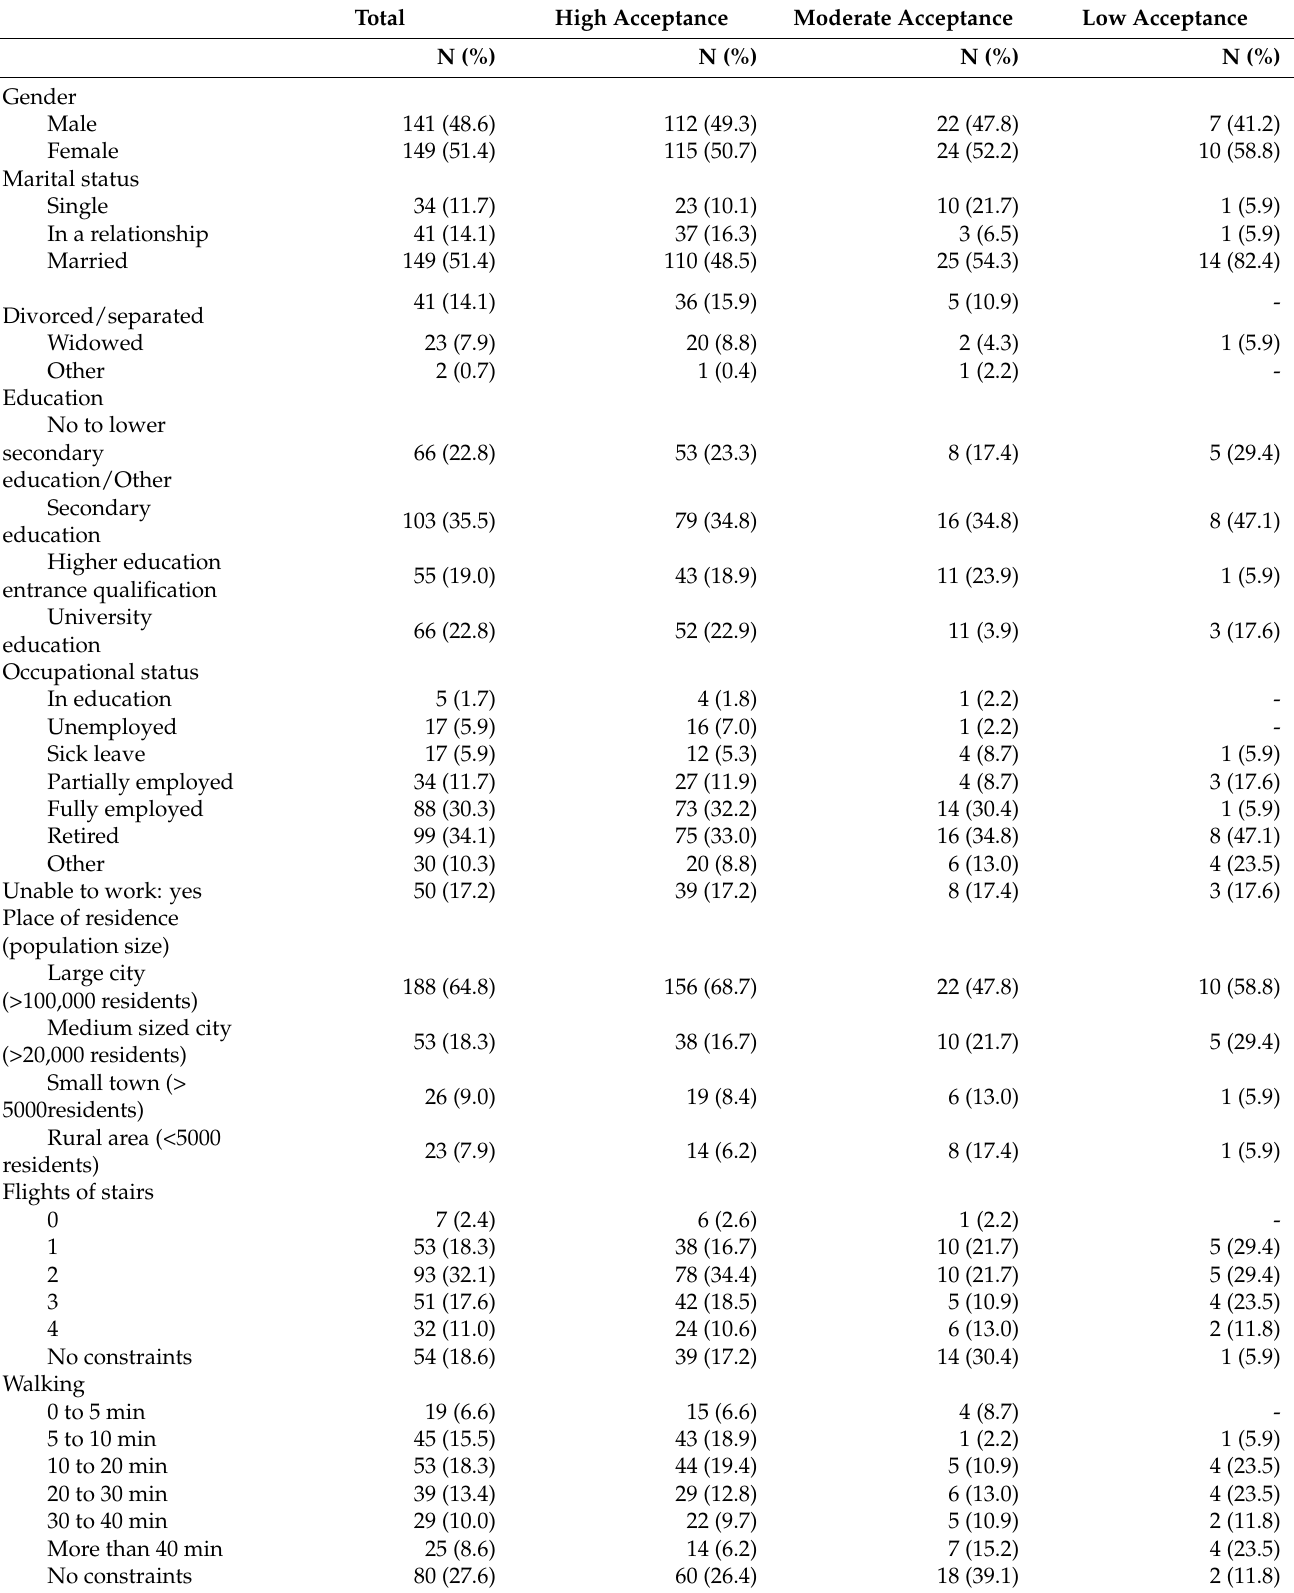
Table 1. Sociodemographic and medical characteristics stratified by acceptance